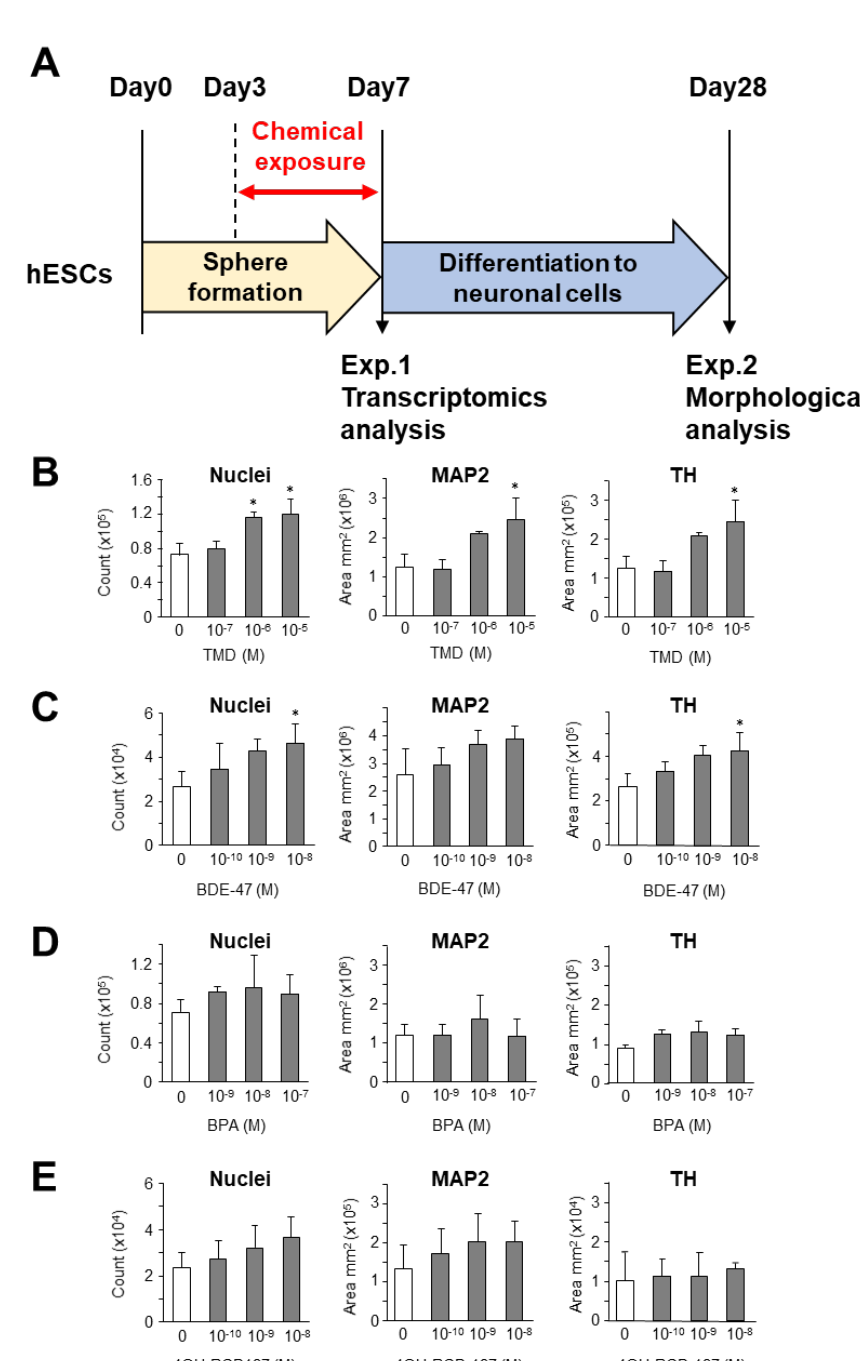
Figure 1. Morphological analysis of the effect of chemical exposure on neuronal differentiation from human embryonic stem cell (hESC)-derived spheres. ( A ) Experimental protocol of sphere formation and neuronal differentiation from hESCs. Dose-dependent effects of exposure to ( B ) thalidomide (TMD), ( C ) 2,2′,4,4′-tetrabromodiphenyl ether (BDE-47), ( D ) bisphenol A (BPA), and ( E ) 4-hydroxy-2,2′,3,4′,5,5′,6-heptachlorobiphenyl (4OH-PCB187) at the early stage of development on the number of cell nuclei and microtubule-associated protein 2 (MAP2)-positive and tyrosine hydroxylase (TH)-positive areas during neuronal differentiation from hESC-derived spheres. The data are represented as mean ± standard deviation of at least three biological replicates. * p < 0.05, analysis of variance (ANOVA)